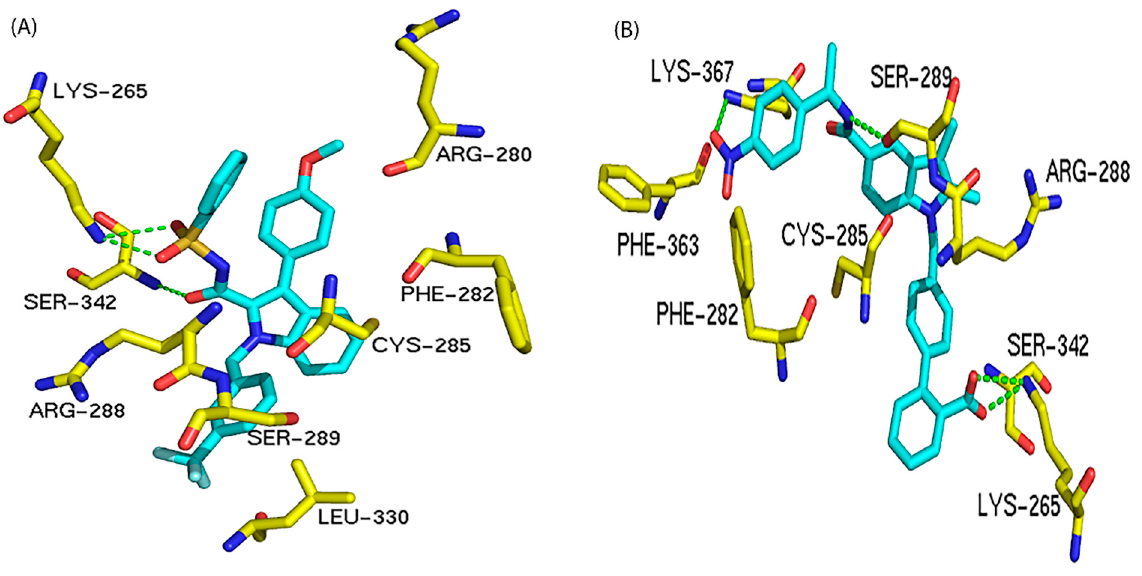
Figure 4. Interactions between PPAR γ and different antagonists at the allosteric binding site. The H-bond interactions are depicted as green dotted lines. ( A ) Interactions between PPAR γ and NSI (an antagonist). ( B ) Interactions between PPAR γ and compound SR1664 (an antagonist).